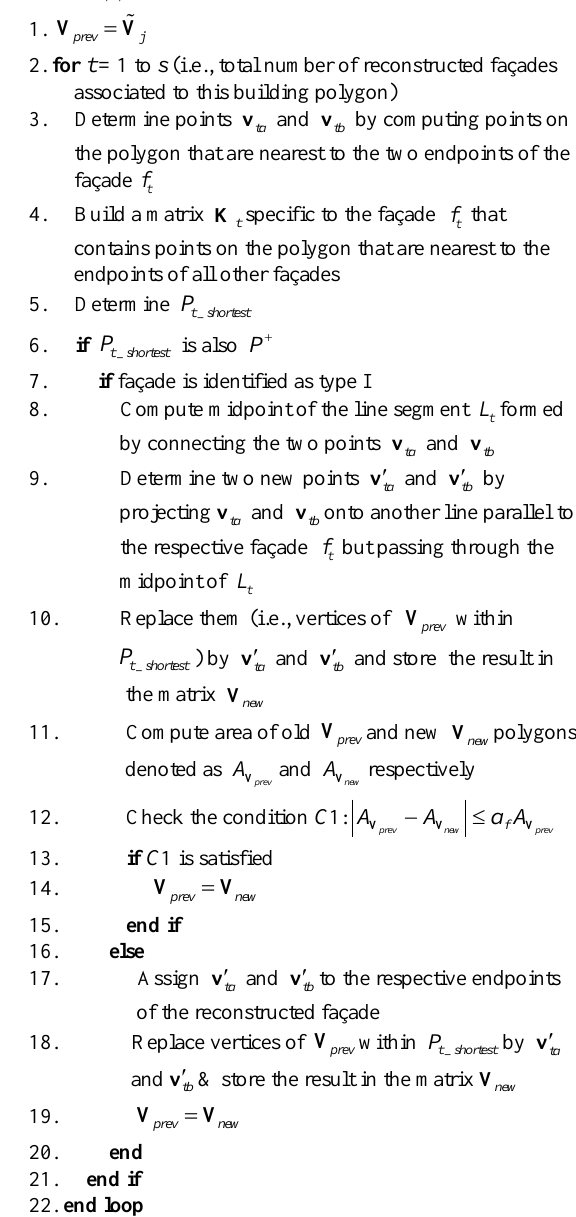
Table 2: Procedure to fuse façades of both types. Note that there lies some differences in computation of  v for type I and II façades (steps 8-9 and 17 in ). The tb